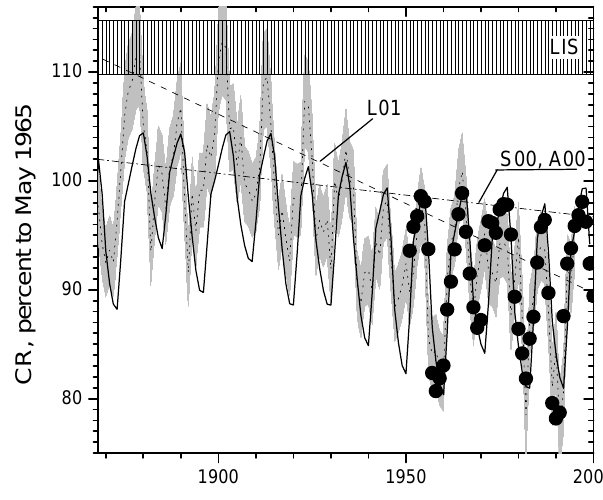
Fig. 2. Climax NM count rates (in percent to May 1965). Dot- ted curve with grey shading denotes the count rate reconstructed from the F s series in L01. Solid curve denotes the reconstruction by Usoskin et al. (2002a). Solid circles correspond to the actual Climax NM count rates for 1951–2000. The hatched LIS area cor- responds to an estimate of the local interstellar CR spectrum with uncertainties. Dashed L01 and dash-dotted S00, A00 lines repre- sent the trend estimated for L01 reconstruction and the largest pos- sible negative trend according to Ahluwalia (2000); Stozhkov et al. (2000),